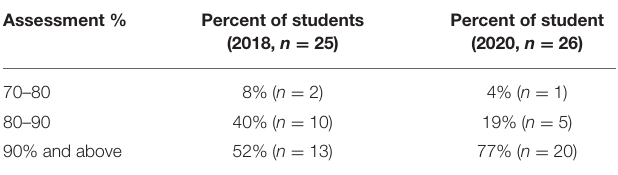
TABLE 3 | Assessment of student work reflecting the integration of ITB knowledge. Assessment